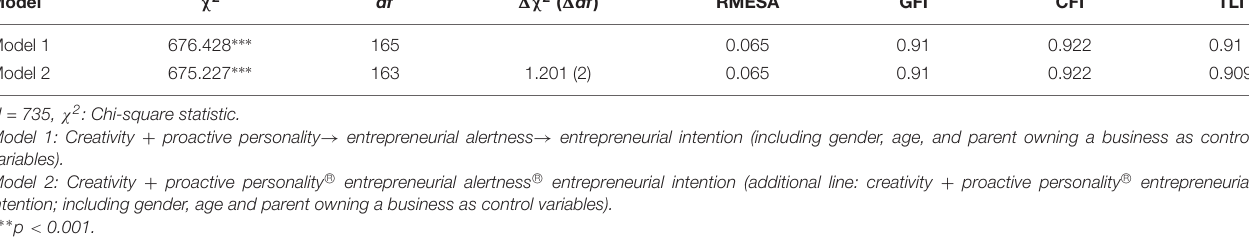
TABLE 2 | Comparison of structural equation models (Models 1 and 2).